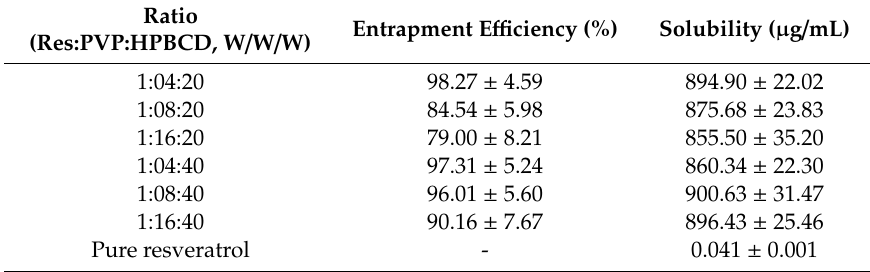
Table 2. Entrapment e ffi ciency and water solubility of di ff erent ratio formulations of resveratrol nanofibers determined by HPLC analysis.